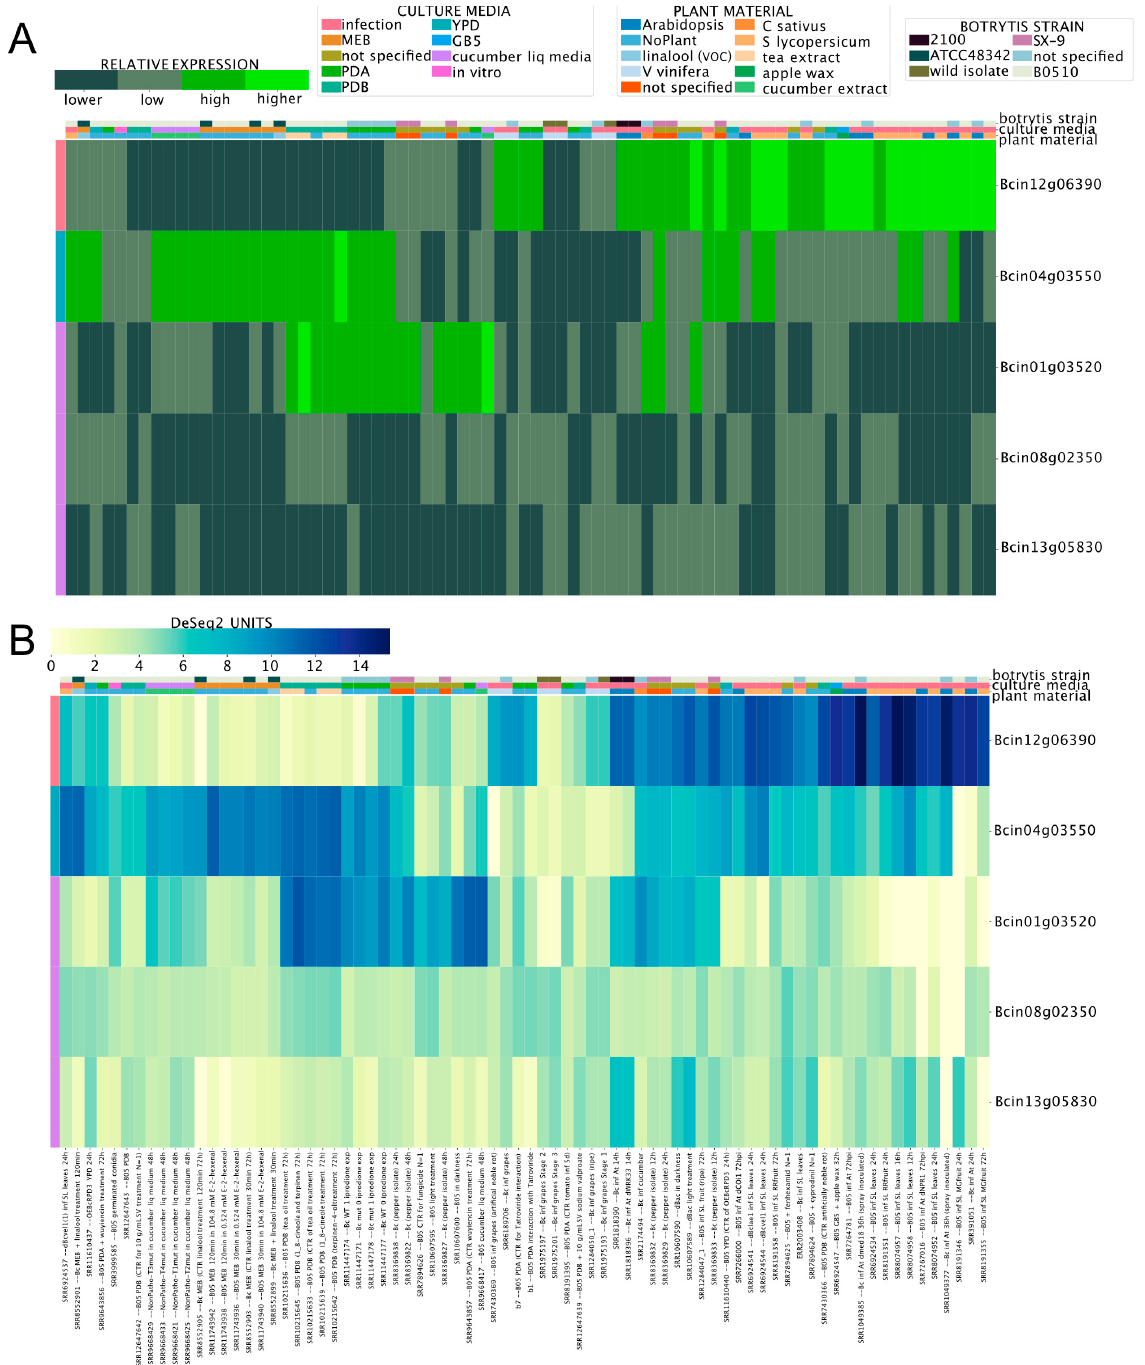
Figure 3. Expression patterns of five sesquiterpene cyclase enzyme-encoding genes. ( A ) Heatmap depicting the mRNA expression levels employing the BEB quartile-categorized expression option (lower: dark green; higher: light green). A continuous color scale ( B ) from low to high expression (yellow to dark blue, respectively) is also shown for comparative purposes. A color code at the top of each heatmap denotes culture conditions and B. cinerea strains. Experimental conditions and analyzed genes are indicated in columns and rows, respectively. Gene IDs are indicated at the right of each heatmap. A detailed description of each experiment is provided at the bottom of the figure, including SRA IDs for reference.